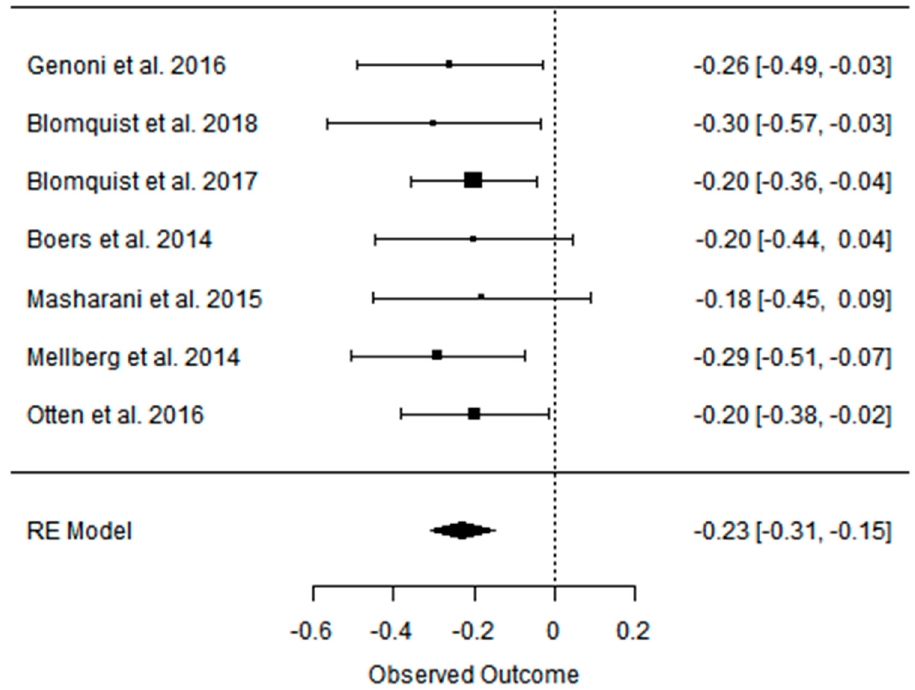
Figure A25. Forest plot of the effect of a CD on LDL-C in the short term (weighted mean difference).